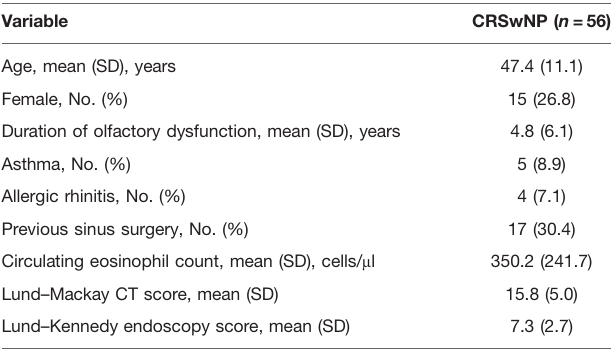
TABLE 1 | Characteristics of study patients with CRSwNP ( n